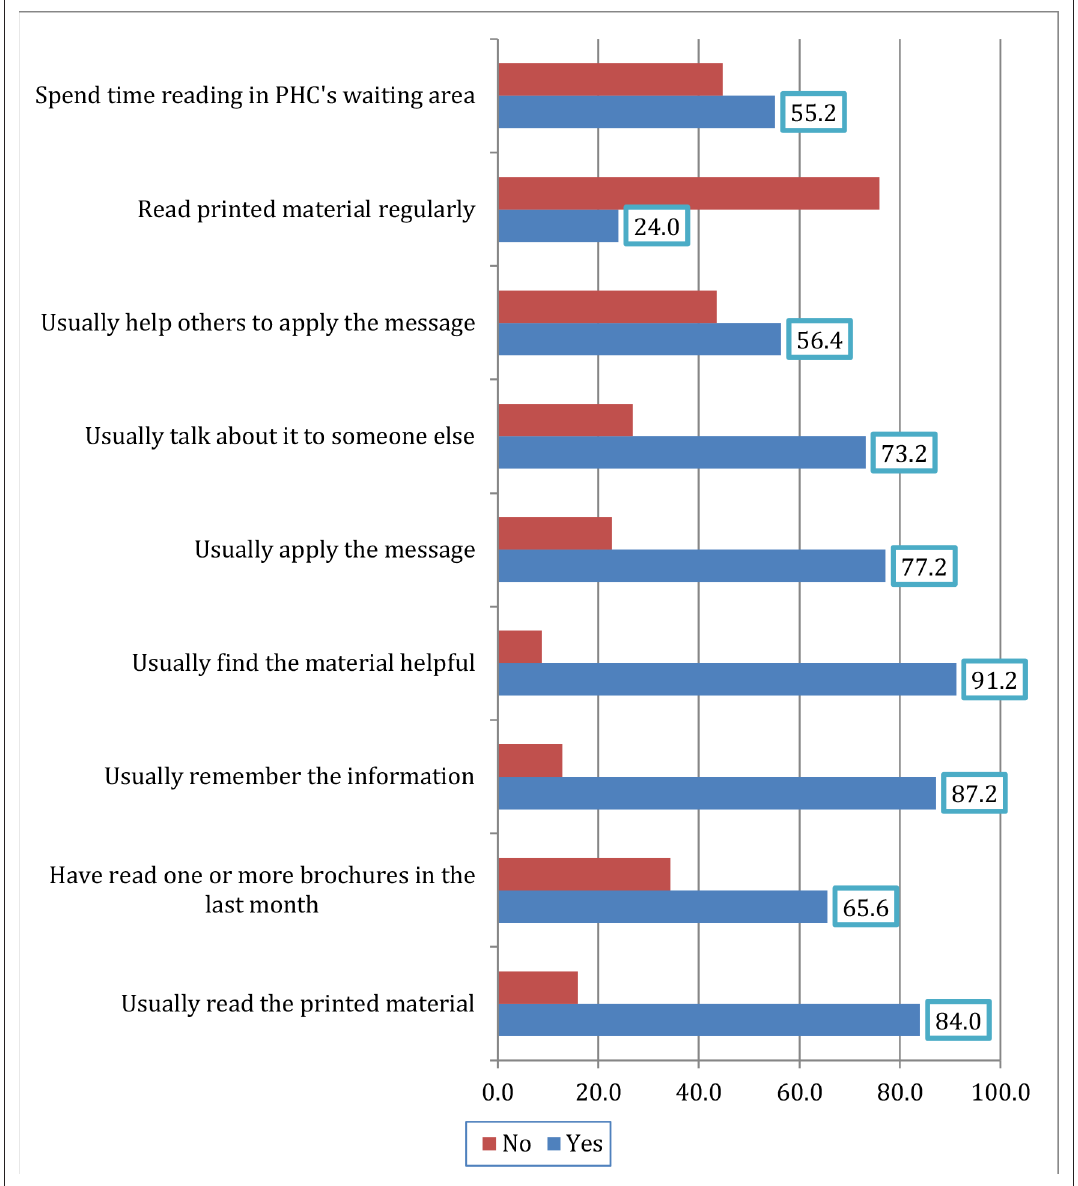
Figure 1 Participants' use of printed health education materials in